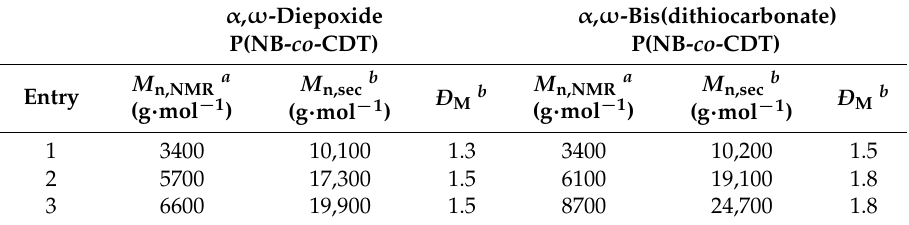
Table 4. Macromolecular characteristics of α , ω -bis(dithiocarbonate) P(NB- co -CDT) copolymers. α , ω -Diepoxide α , ω -Bis(dithiocarbonate) P(NB- co -CDT) P(NB- co -CDT)